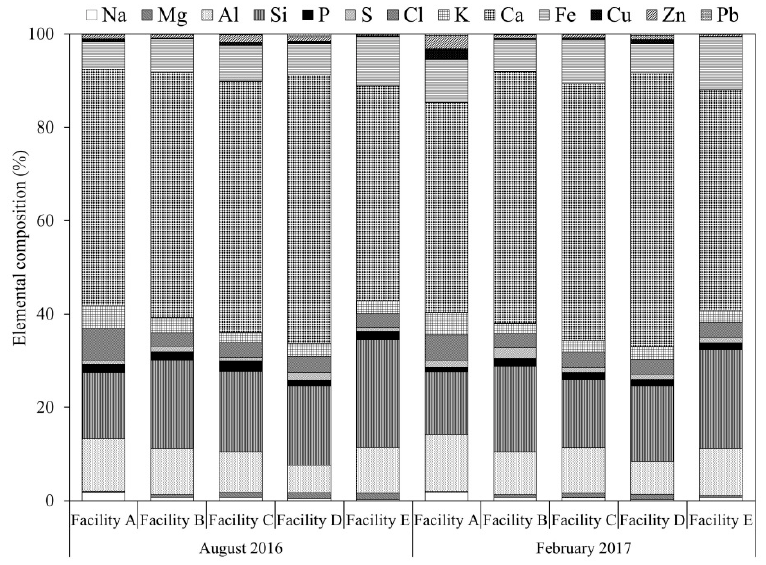
Figure 1. Elemental composition of bottom ash (BA) determined using energy dispersive X-ray fluorescence spectroscopy.